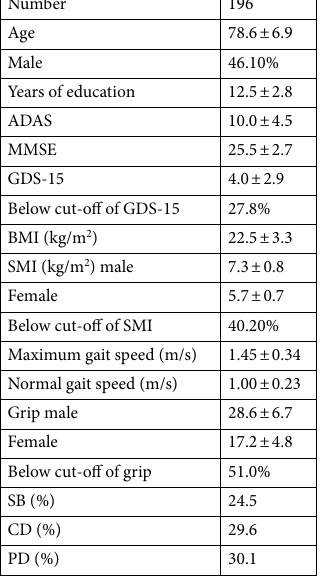
Table 1. Participant characteristics. Mean ± Standard deviation was shown. Cut-off point for GDS-15 was 5/6. Cut-off point for handgrip strength of < 28 kg for men and < 18 kg for women; cut-off for low SMI was < 7.0 kg/m 2 in men and < 5.7 kg/m 2 in women. ADAS Alzheimer’s disease assessment scale, MMSE